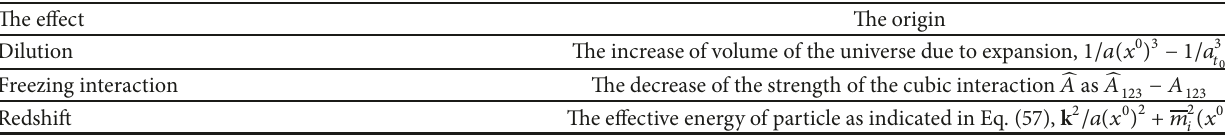
) contributions to the 0